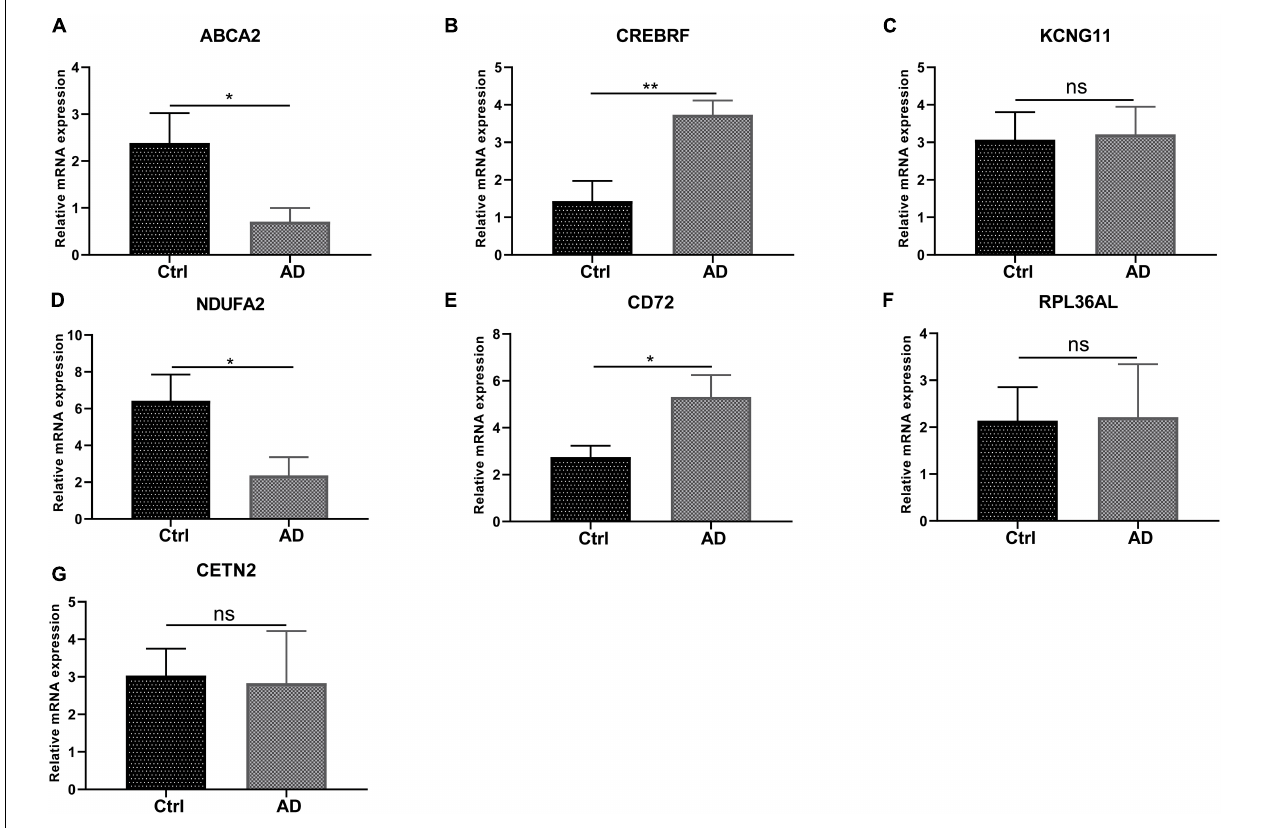
FIGURE 8 | RT-PCR validation of the hub gene between AD and normal controls. (A-G) All experiments were carried out three times, and the data were expressed as mean ± SEM (* p < 0.05, ** p < 0.01, ns, no significance).